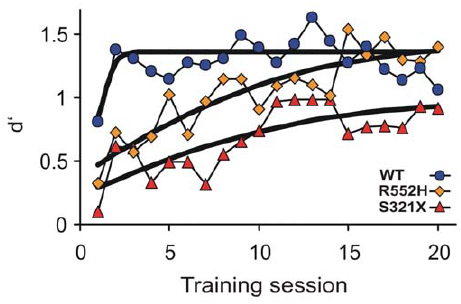
Figure 3. Spontaneous motor behavior. Mean numbers of spontaneous jumps across the hurdle of the shuttle-box during the three minutes before the beginning of the daily training session. At the first training day, WTs show significantly more spontaneous jumping compared to both types of heterozygous mutants (*** p , 0.001 in each case; F-value of the ANOVA=14.92). At the second training day, the WTs show significantly more jumps than the heterozygous R552H mutants (p , 0.02 **; F-value of the ANOVA=5.12). For training days 3– 13, 18 and 20 the ANOVA-tests did not lead to significant differences, F , 3.42). WTs showed more spontaneous jumps compared to both mutants (p , 0.05*; F . 5.30) on days 17 and 19, and compared to R552H mutants (p , 0.05*; F . 4.40) on days 14–16. Standard deviations of the means are shown only for one side to improve readability of the data.